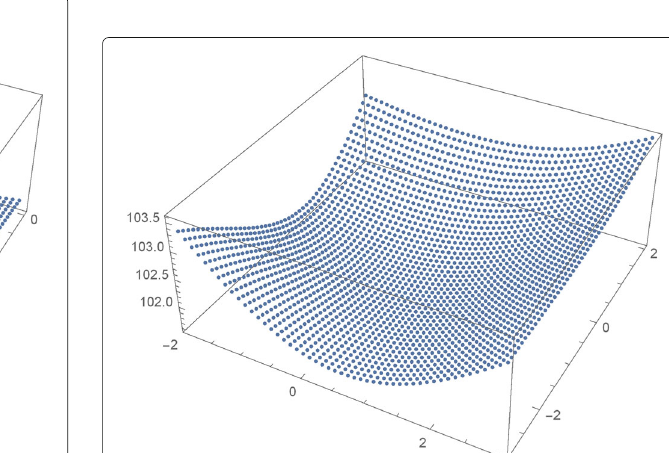
Fig. 8 Variance of the procurement cost V [ C ]